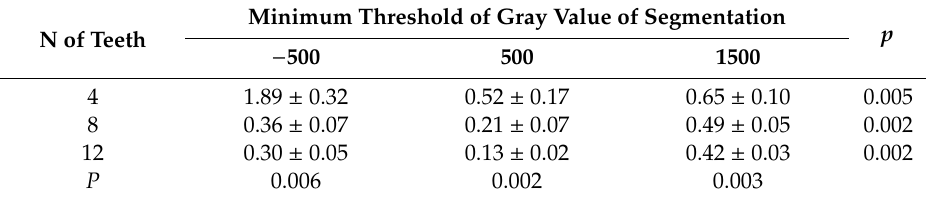
Table 1. Image registration error (mm) between the optical scan and 3D-reconstructed radiographic images.